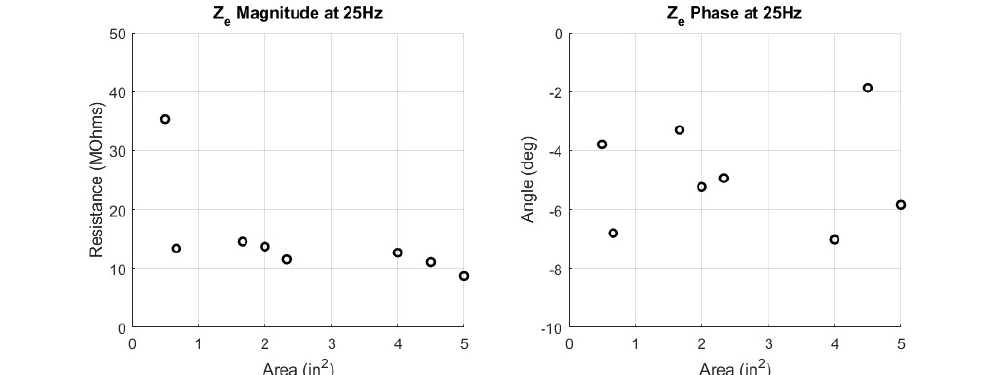
Figure 8. Surface Area Comparison versus Impedance Z e ; Yarn = Spun Steel, Pattern = 1/15 Sateen, Magnitude ( left ), Phase ( right